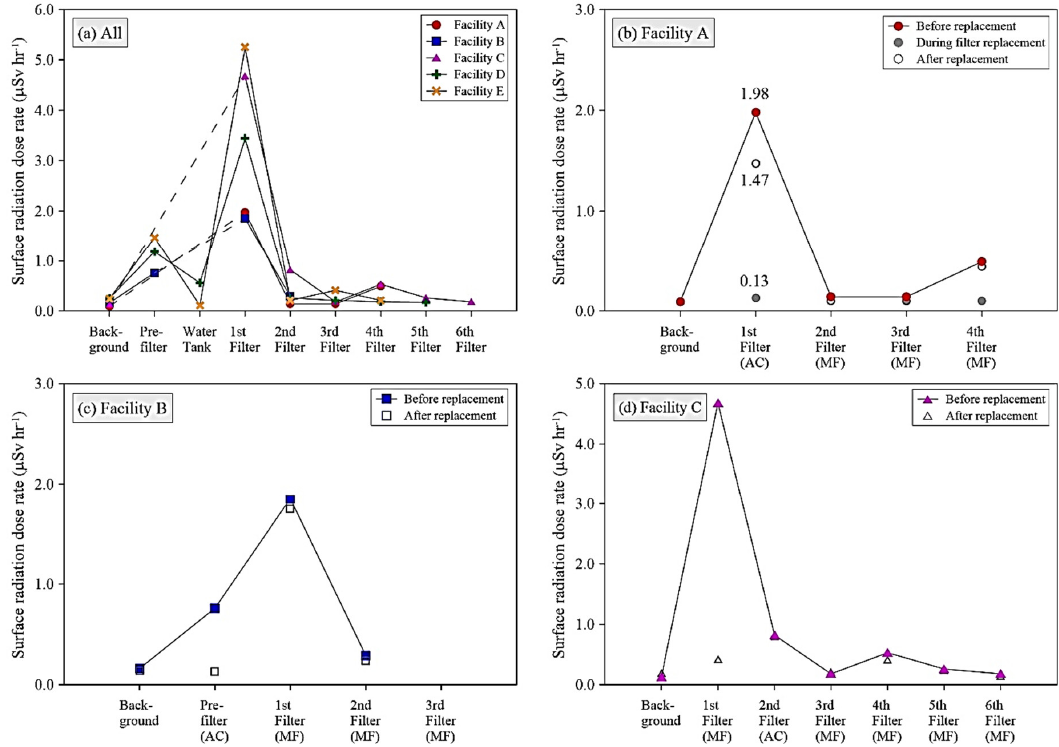
Figure 2. Changes in the surface radiation dose rate through the water treatment processes at individual bottled mineral-water facilities: ( a ) All facilities, ( b ) Facility A, ( c ) Facility B, and ( d ) Facility C. Surface radiation dose rate was measured at a distance of 0.1 m from the filter housing. The dashed lines in the upper left figure indicate no filters or equipment in the relevant facilities.